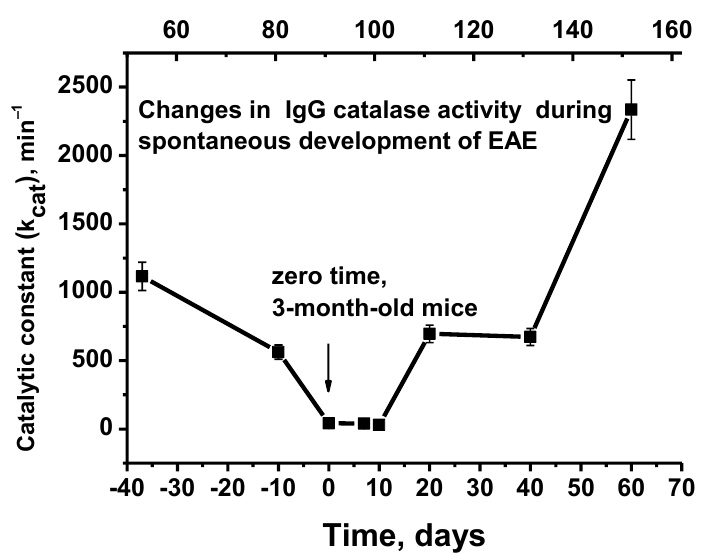
Figure 3. Changes over time of the average catalase activity of IgGs (7 mice in each group) during the spontaneous development of EAE before immunization in mice. The upper scale corresponds to the total number of days of the experiments, while the lower scale indicates the beginning of the experiments (zero time; 3-month-old mice), with the mice being immunized with MOG and the DNA – histone complex. The changes in catalase activity after immunization are shown in Figure 4.